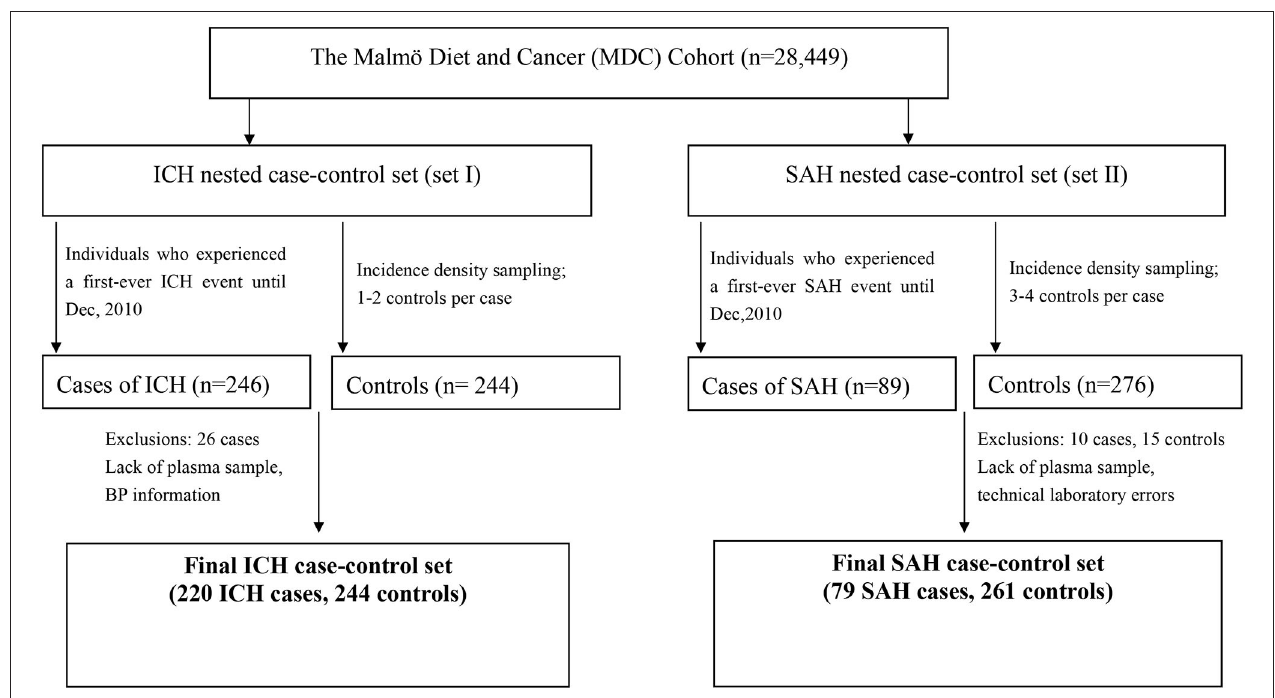
FIGURE 1 | Participants included in the nested case-control studies of GDF-15 levels and ICH and